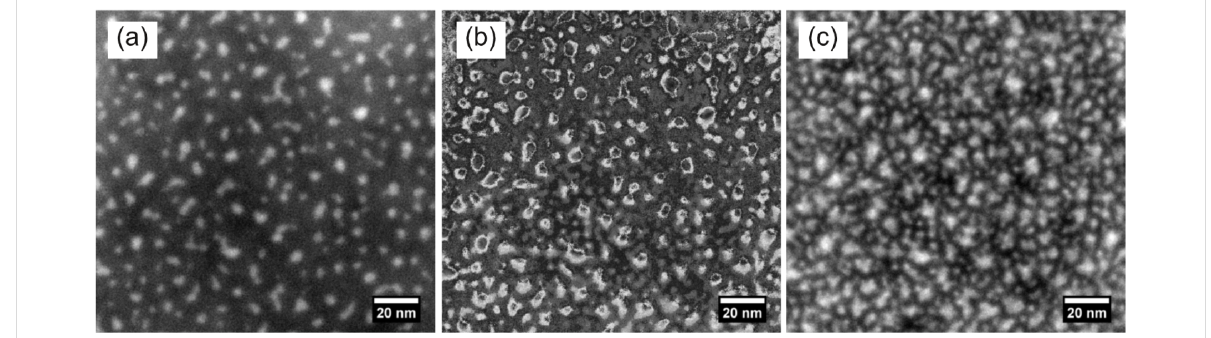
Figure 1: EFTEM images of S1: (a) image in fresh area, (c) after about 10 min exposure to an intense electron beam and (b) XOR image of (a) and (c) highlighting the change between the two as denoted by white regions. Nanoparticles obviously grow and even new ones are created.